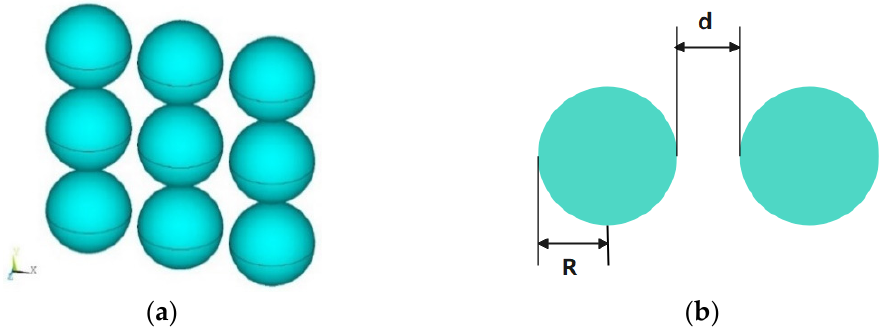
Figure 4. Structure of the silver nanosphere array. ( a ) 3D view; ( b ) dimensions of the nanosphere array, where d = 5 nm, R = 20 nm.